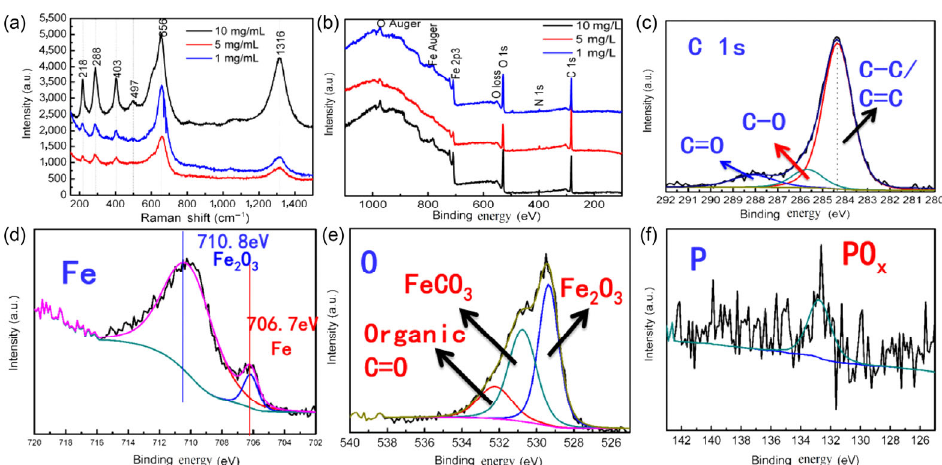
Fig. 28 Raman and XPS analysis of the worn surfaces on steel disks lubricated with the various concentration of BP-16C: (a) Raman of the worn surfaces; (b) XPS of the worn surfaces; (c) C, (d) Fe, (e) O, and (f) P obtained from the worn surfaces at the concentration of 1